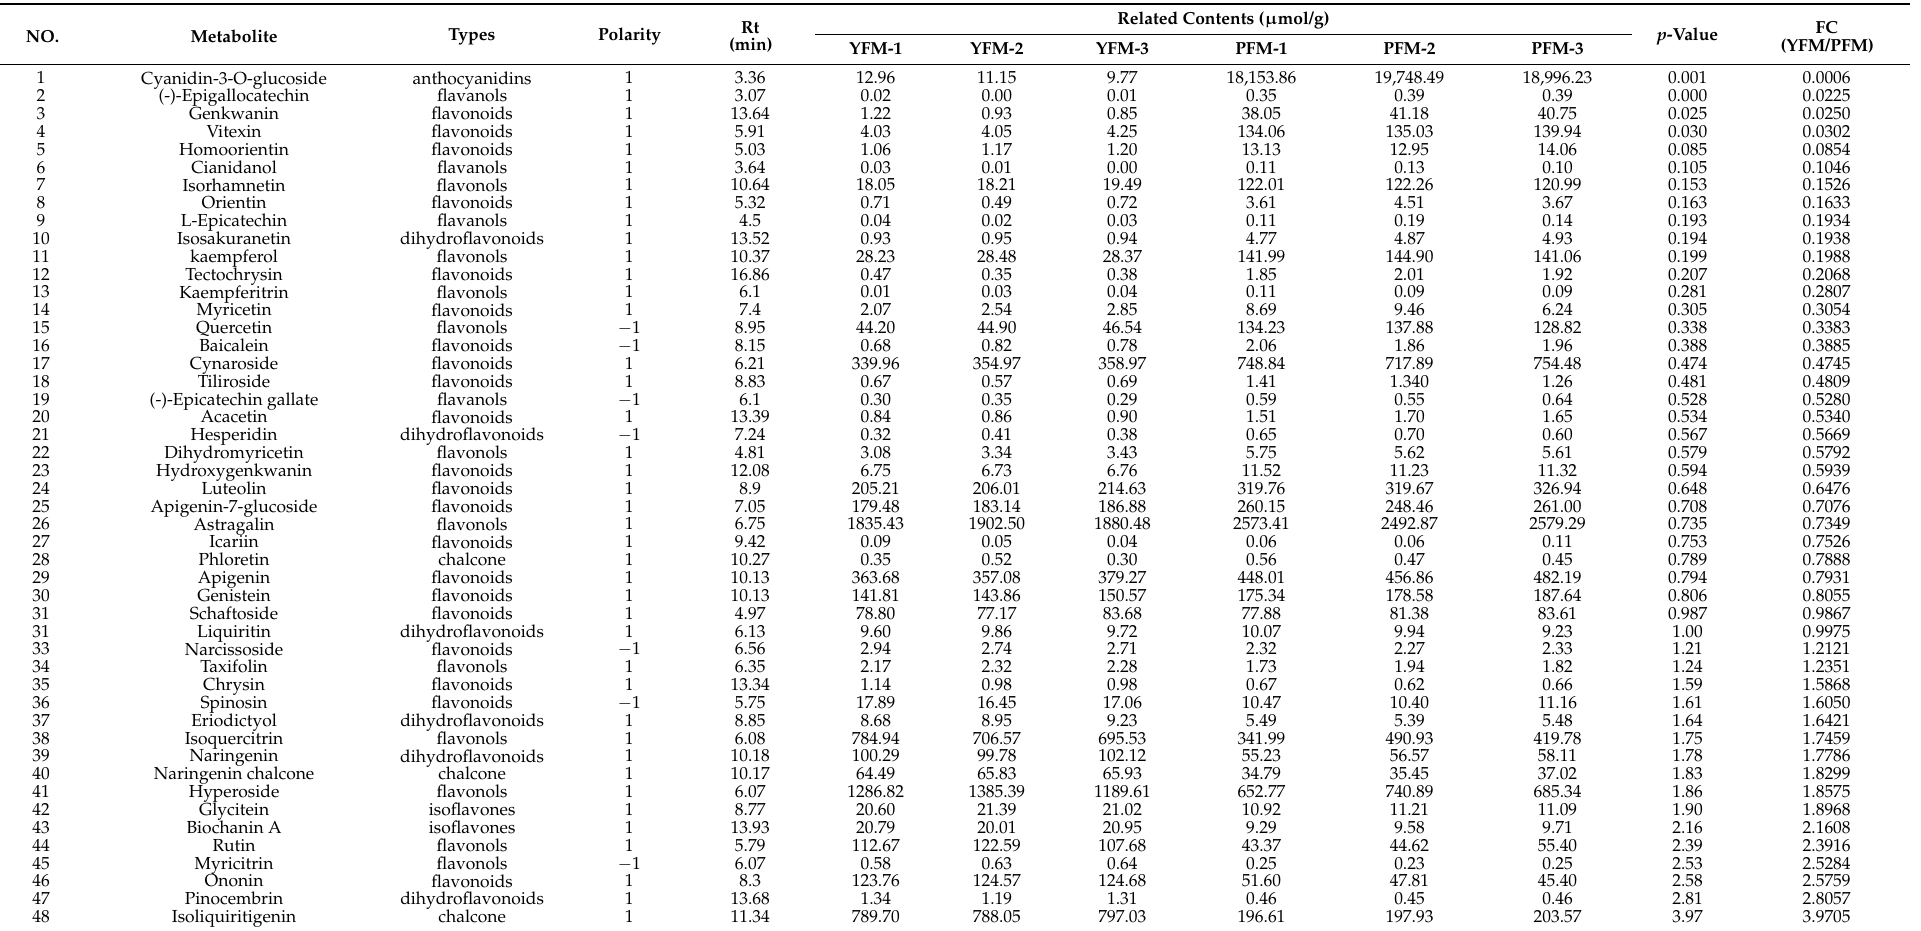
Table 1. Differentially accumulated flavonoid metabolites in YFM and